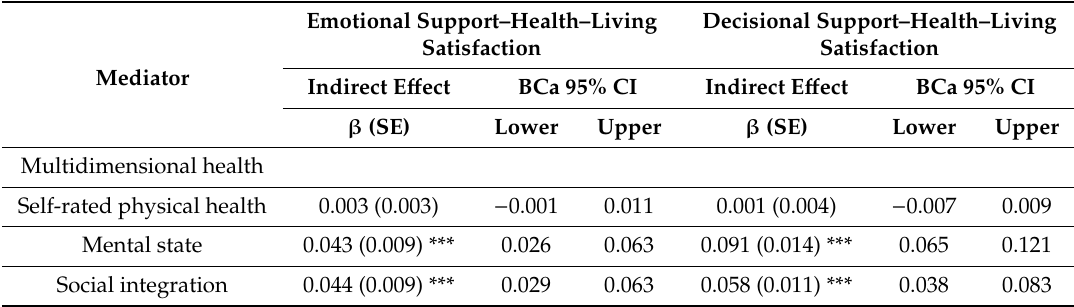
Table 6. The results of the bootstrap analysis test.